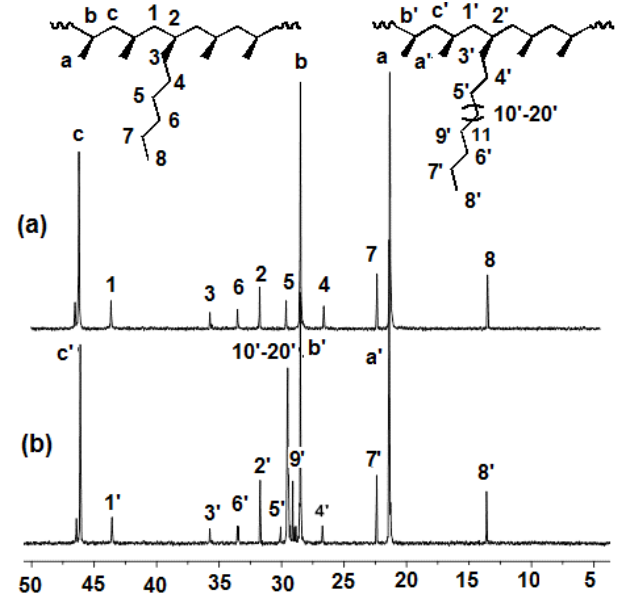
Figure 1. 13 C NMR spectra for: ( a ) P / C8 (1-octene 12.2 mol.%, Table 1, entry 4) and ( b ) P / C20 (1-eicosene 12.2 mol.%, Table 1, entry 16).